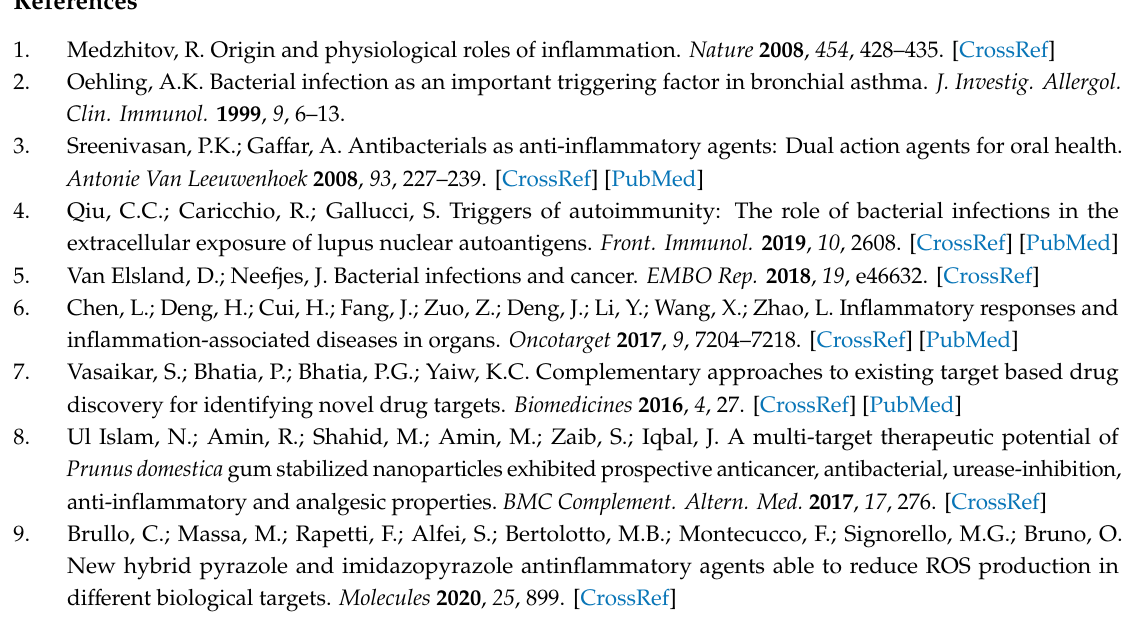
2-enamide ( 7 ). Figure S13: 13 C-NMR (DMSO- d 6 ) spectrum of (2 E )- N -(5-chloro-2-fluorophenyl)-3-phenylprop- 2-enamide ( 8 ). Figure S14: HR-MS record of (2 E )- N -(5-chloro-2-fluorophenyl)-3-phenylprop-2-enamide ( 8 ). Figure S15: 13 C-NMR (DMSO- d 6 ) spectrum of (2 E )- N -(4-bromo-3-fluorophenyl)-3-phenylprop-2-enamide ( 9 ). Figure S16: HR-MS record of (2 E )- N -(4-bromo-3-fluorophenyl)-3-phenylprop-2-enamide ( 9 ). Figure S17: 13 C-NMR (DMSO- d 6 ) spectrum of (2 E )- N -[3-fluoro-4-(trifluoromethyl)phenyl]-3-phenylprop-2-enamide ( 10 ). Figure S18: HR-MS record of (2 E )- N -[3-fluoro-4-(trifluoromethyl)phenyl]-3-phenylprop-2-enamide ( 10 ). Figure S19: 13 C-NMR (DMSO- d 6 ) spectrum of (2 E )- N -(4-bromo-3-chlorophenyl)-3-phenylprop-2-enamide ( 11 ). Figure S20: HR-MS record of (2 E )- N -(4-bromo-3-chlorophenyl)-3-phenylprop-2-enamide ( 11 ). Figure S21: 13 C-NMR (DMSO- d 6 ) spectrum of (2 E )- N -(2-bromo-4-chlorophenyl)-3-phenylprop-2-enamide ( 12 ). Figure S22: HR-MS record of (2 E )- N -(2-bromo-4-chlorophenyl)-3-phenylprop-2-enamide ( 12 ). Figure S23: 13 C-NMR (DMSO- d 6 ) spectrum of (2 E )- N -[2-bromo-5-(trifluoromethyl)phenyl]-3-phenylprop-2-enamide ( 13 ). Figure S24: HR-MS record of (2 E )- N -[2-bromo-5-(trifluoromethyl)phenyl]-3-phenylprop-2-enamide ( 13 ). Figure S25: 13 C-NMR (DMSO- d 6 ) spectrum of (2 E )- N -[4-fluoro-2-(trifluoromethyl)phenyl]-3-phenylprop-2-enamide ( 14 ). Figure S26: HR-MS record of (2 E )- N -[4-fluoro-2-(trifluoromethyl)phenyl]-3-phenylprop-2-enamide ( 14 ). Figure S27: 13 C-NMR (DMSO- d 6 ) spectrum of (2 E )- N -[4-chloro-2-(trifluoromethyl)phenyl]-3-phenylprop-2-enamide ( 15 ). Figure S28: HR-MS record of (2 E )- N -[4-chloro-2-(trifluoromethyl)phenyl]-3-phenylprop-2-enamide ( 15 ). Figure S29: 13 C-NMR (DMSO- d 6 ) spectrum of (2 E )- N -[4-bromo-2-(trifluoromethyl)phenyl]-3-phenylprop-2-enamide ( 16 ). Figure S30: HR-MS record of (2 E )- N -[4-bromo-2-(trifluoromethyl)phenyl]-3-phenylprop-2-enamide ( 16 ). Figure S31: 13 C-NMR (DMSO- d 6 ) spectrum of (2 E )- N -[4-nitro-2-(trifluoromethyl)phenyl]-3-phenylprop-2-enamide ( 17 ). Figure S32: HR-MS record of (2 E )- N -[4-nitro-2-(trifluoromethyl)phenyl]-3-phenylprop-2-enamide ( 17 ). Figure S33: 13 C-NMR (DMSO- d 6 ) spectrum of (2 E )- N -[4-nitro-3-(trifluoromethyl)phenyl]-3-phenylprop-2-enamide ( 18 ). Figure S34: HR-MS record of (2 E )- N -[4-nitro-3-(trifluoromethyl)phenyl]-3-phenylprop-2-enamide ( 18 ). Figure S35: 13 C-NMR (DMSO- d 6 ) spectrum of (2 E )- N -[2,6-dibromo-4-(trifluoromethyl)phenyl]-3-phenylprop-2-enamide ( 19 ). Figure S36: HR-MS record of (2 E )- N -[2,6-dibromo-4-(trifluoromethyl)phenyl]-3-phenylprop-2-enamide ( 19 ). Figure S37: 13 C-NMR (DMSO- d 6 ) spectrum of (2 E )- N -(2,6-dibromo-3-chloro-4-fluorophenyl)-3-phenylprop-2-enamide ( 20 ). Figure S38: HR-MS record of (2 E )- N -(2,6-dibromo-3-chloro-4-fluorophenyl)-3-phenylprop-2-enamide ( 20